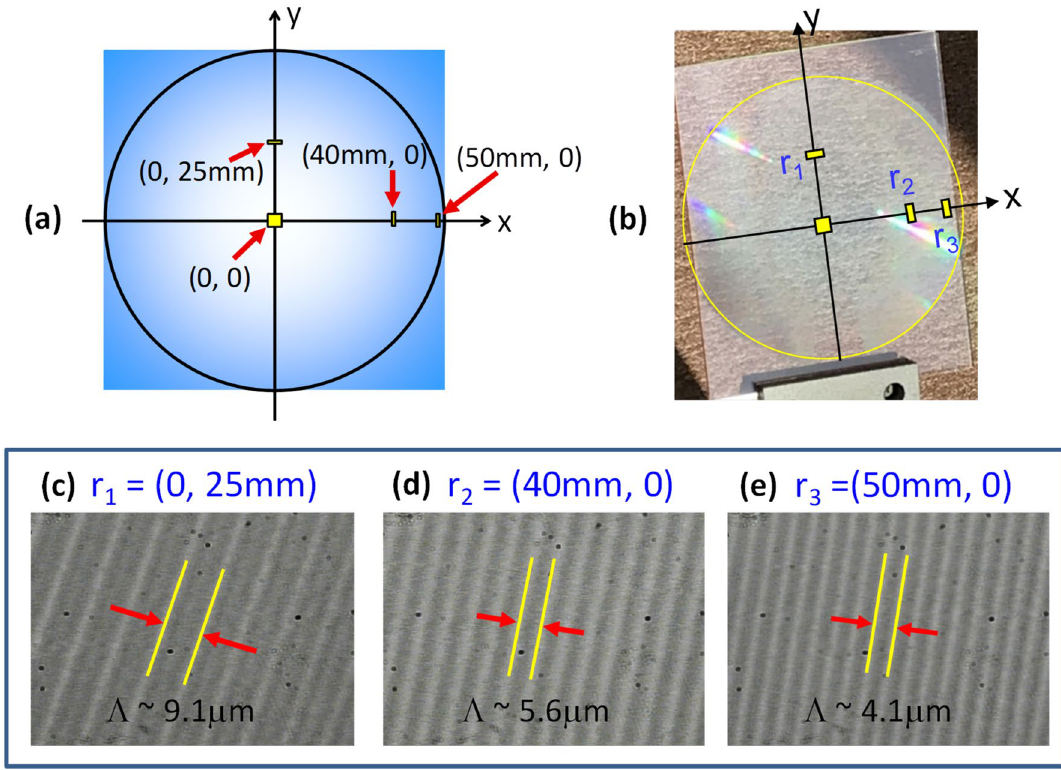
Figure 5. ( a ) A schematic of the hologram coordinate at z = 0 plane, where both the reference and object point sources are positioned along the z-axis. ( b ) A photo of the recorded 4 × 5 inch 2 Fresnel hologram on a glass plate. ( c – e ) Optical images of the recorded grating structure taken at different points, r 1 , r 2 and r 3 , on the Fresnel hologram. The grating pitch Λ becomes denser as the observation point is further away from the hologram ( λ i z 30 ), the detection length Δ z , as well as λ 2 . This explains our earlier observation in Fig. 6b that the spectral linewidth Δ λ FWHM is wider for longer- λ peaks. Also, when λ is increased from 450 to 650 nm, the theory predicts a (650/450) 2 ~ 2 × increase of linewidth which agrees with the observation shown in Fig. 5b. As a specific (cid:31) (cid:31) z (cid:31) z 1.33 10 − 3 nm/ z 30 example, when λ = λ i = 515 nm and z 30 = 388 mm, we have (cid:31) (cid:31) ∼= i = − × × × − µm. When Δ z = 50 µm, 5 µm, and 0.5 µm, the spectral resolution of the hologram is |Δ λ | = 0.0665, 0.00665 and (cid:30) (cid:29) (cid:31) 0.000665 nm, respectively. And, the corresponding spectral resolvance ( λ /Δ λ ) is 7.74 × 10 3 , 7.74 × 10 4 , and 7.74 × 10 5 , respectively. A resolvance of 7740 to 77,400 is in the medium to high resolution range and is a good range for determining stellar properties and radial velocities of stars in the Milky Way galaxy. A resolvance of 774,000 is in the super-resolution range for the detection of exoplanets by the radial velocity method. Noted that, to extract a selective bandwidth of light over a length Δz, a secondary optics can be used to diffract light away from the z-axis for an easy and full spectral analysis. A schematic of the approach by a diffracted optical element is illustrated in the inset of Fig. 7a. Alternatively, a fiber or detector may be placed facing the z to collect starlight, such as shown in the photo of Fig. 6a . In this case, the minimum detector size d is set by the diameter of the Airy disk 13 of our Fresnel hologram, i.e., d ≥ d Airy . For our Fresnel hologram, its diameter is D = 10 cm and the corresponding diameter of (cid:31) i z 30 (cid:31) z 3 2.44 4.8 µm. Interestingly, since d 2.44 Airy disk is d Airy Airy depends on intrinsic param- D = D = × = × eters such as λ i and z 30 and D , its value remains the same for all wavelengths or it is Δ λ -independent. Addi- tionally, if we increase the diameter of our hologram to D ’ = 1 m, the corresponding Airy disk is reduced to (cid:31) i z 30 1.22 (cid:31) i 1.22 (cid:31) i 0.5 µm. Here, the N.A. (Numerical Aperture) of holographic lens is 2.44 d ′ Airy = D ′ = N . A . ∼ ≈ × close to 1 and the recording wavelength λ i is 405 nm. It is this diffraction limit that determines the minimum d of a photodetector to be used and, therefore, the minimum Δ z for starlight collection. According to the geometry shown in Fig. 7a, the amount of light collected over a diameter d ( ≡ Δ y ) is equiva- lent to those light distributed over a length Δ z along the z axis. If the light incident angle is θ, we have � y R 20 � z θ tan − 1 3.0 o . We may now re-examine the experimental configu- tan − 1 2 tan θ . Here, 388 z 30 = = = (cid:31) (cid:30) = × (cid:28) (cid:29) ration and spectral linewidth shown in Fig. 6a,b, respectively. Since the fiber has a diameter d = Δ y = 400 μm, the � y 400 10 − 3 4 mm. By Eq. (5), the predicted spectral linewidth corresponding detecting length � z × 2 tan θ = 2 0.05 = = � (cid:31) � z µ m × × 1.33 10 − 3 nm 5.3 nm at z ∼= 30 = 388 mm. This finding agrees with the measured results | | ∼= × × shown in Fig. 6b within ~ 2 nm. (cid:31) Separately, the Fresnel hologram may be utilized for a sensitive starlight detection. We will estimate the minimum detectable power of a micro-PMT detector and then examine the star light flux of alpha Lyrae, the 5th brightest star in the night sky. A typical micro-PMT has a noise level V noise = 6 mV for a detector area